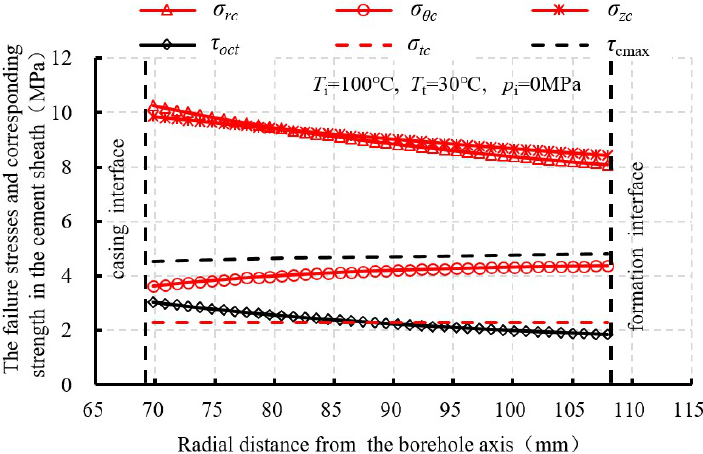
Figure 13. Radial distribution of the failure stress and corresponding strength of the cement sheath under only a decreased temperature of 70 °C at the casing inner wall.